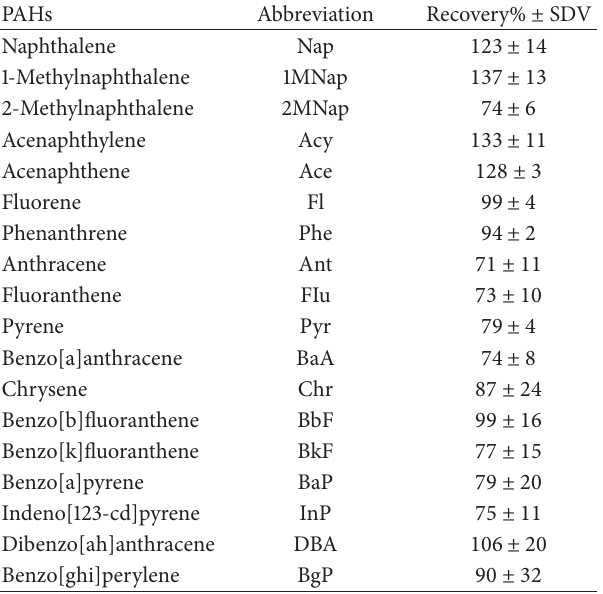
Table 2: Average recovery of 18 PAHs in marine sediment (SRM